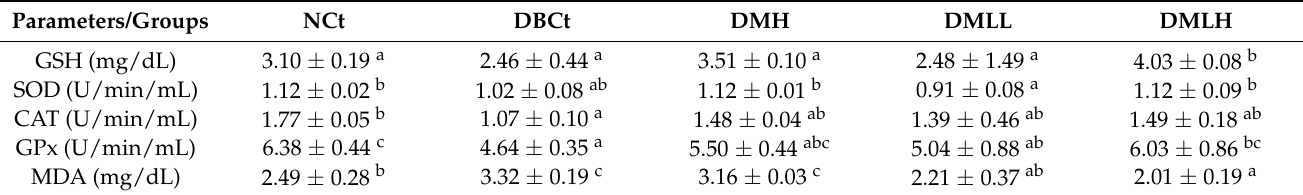
Table 2. Oxidative stress status of the animals in different groups at the end of the experimental period. Parameters/Groups